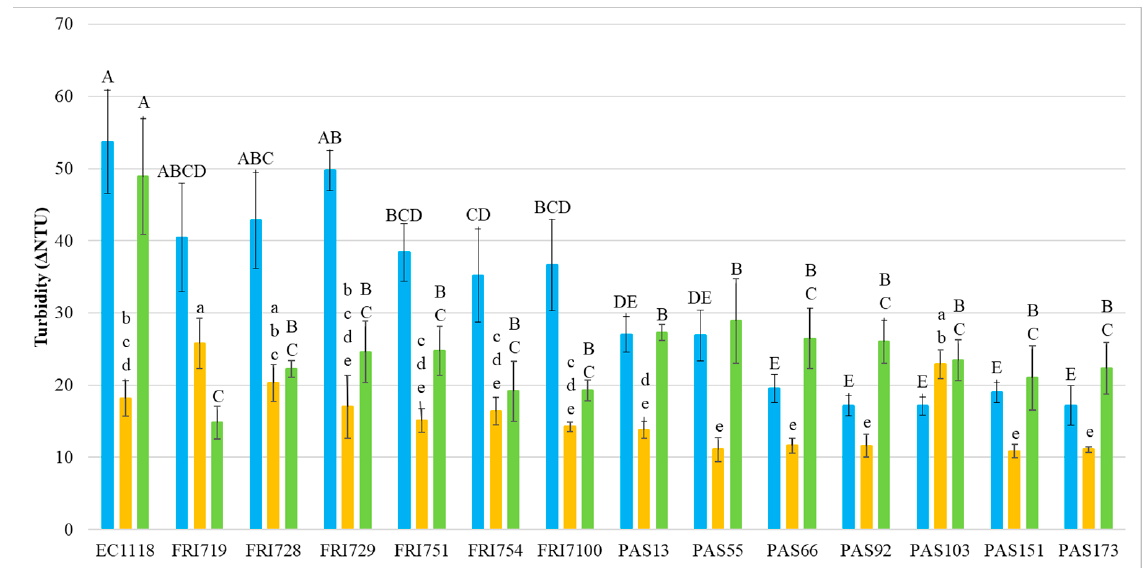
Figure 1. Heat stability (expressed as Δ NTU) in S. cerevisiae (EC1118) and S. bacillaris sequential fermentations. ■ Sauvignon blanc ■ Pinot grigio ■ Manzoni bianco. Values are represented by the average (bars) and standard deviation (error bar) ( n = 3). The difference between the averages was analyzed by one-way ANOVA and Tukey post hoc tests. Different letters indicate significant statistical differences p < 0.05 (Tukey’s test) among the fermentation trials.